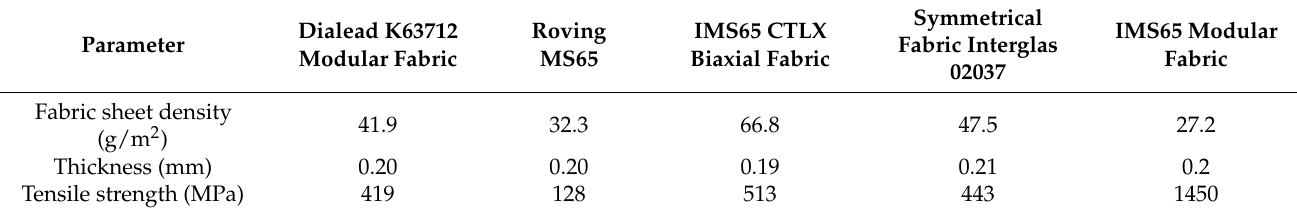
Table 1. Parameters of fabrics used as reinforcement of